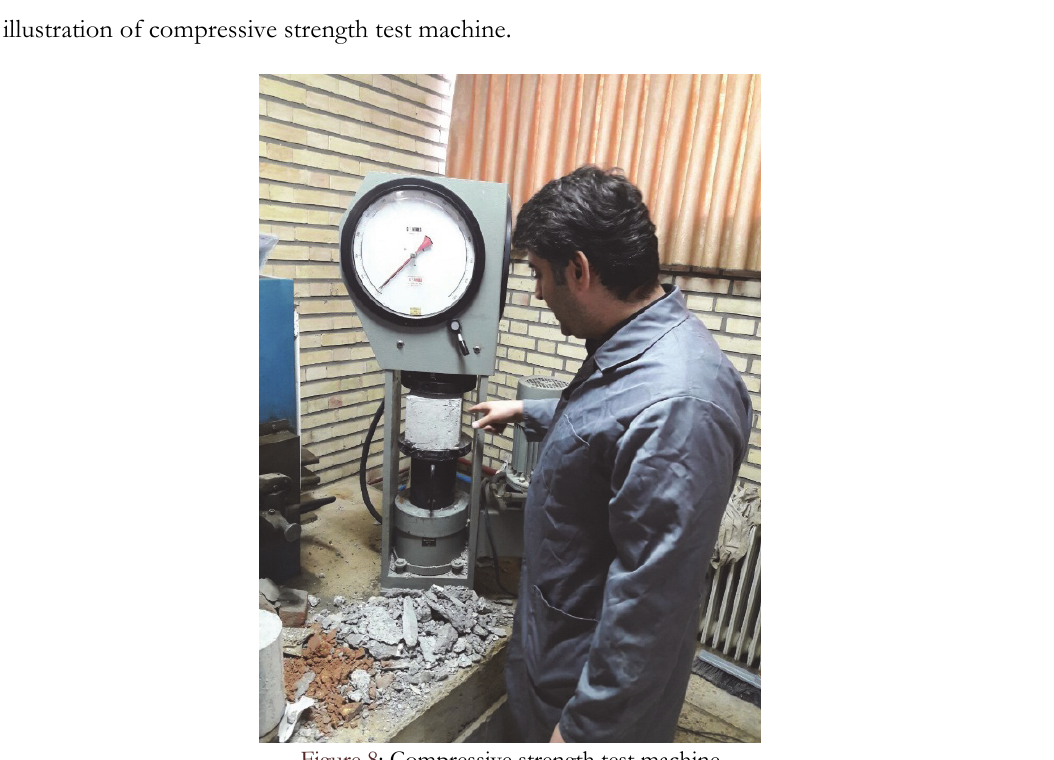
Figure 8: Compressive strength test